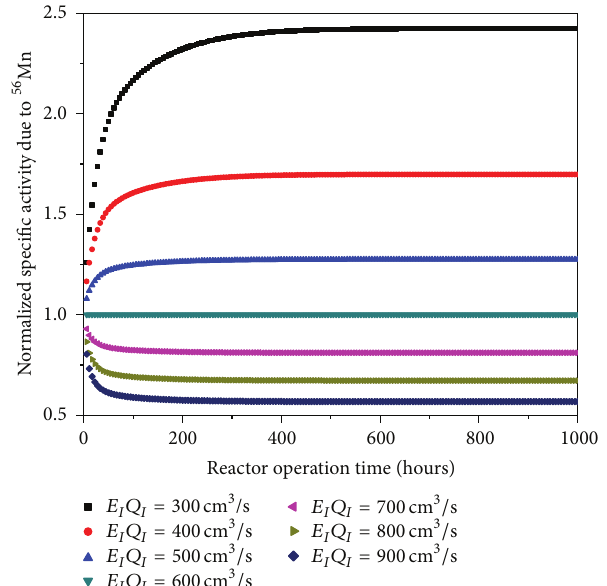
Figure 2: Normalized specific activity due to 56 Mn as a function of different removal rates.